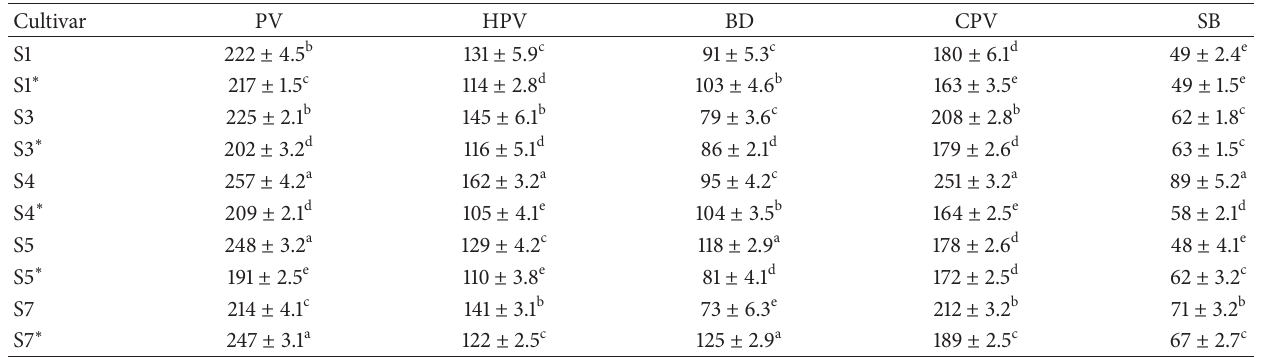
Table 4: Pasting properties x of native and hydroxypropylated ∗ sweet potato starch. Cultivar